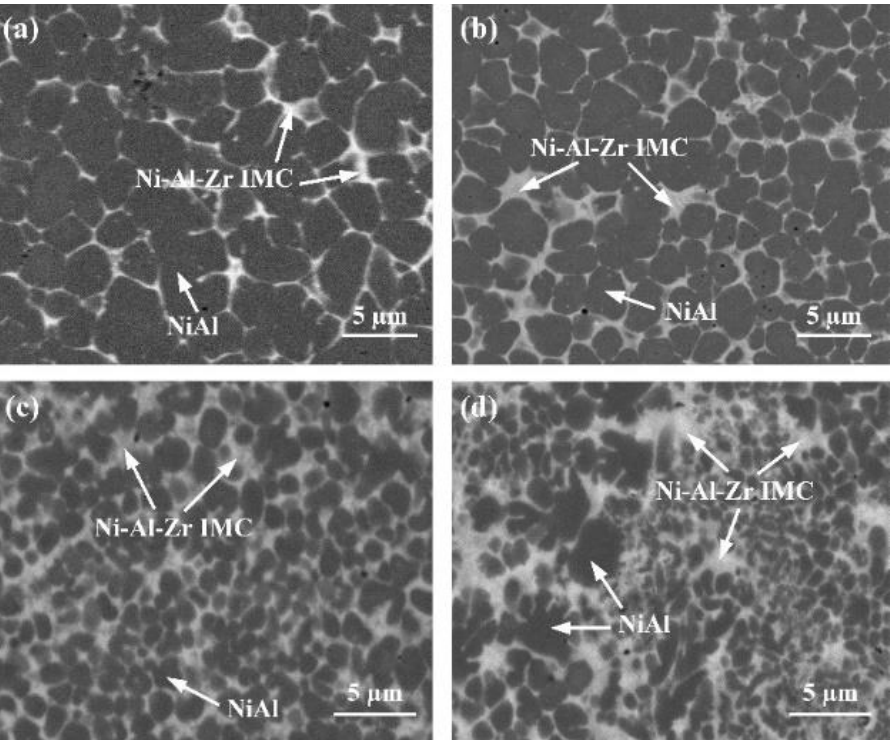
Figure 9. Microstructures of the different interlayer products. ( a ) Zr 5 wt.%; ( b ) 8 wt.%; ( c ) 15 wt.%; ( d ) 20 wt.%.